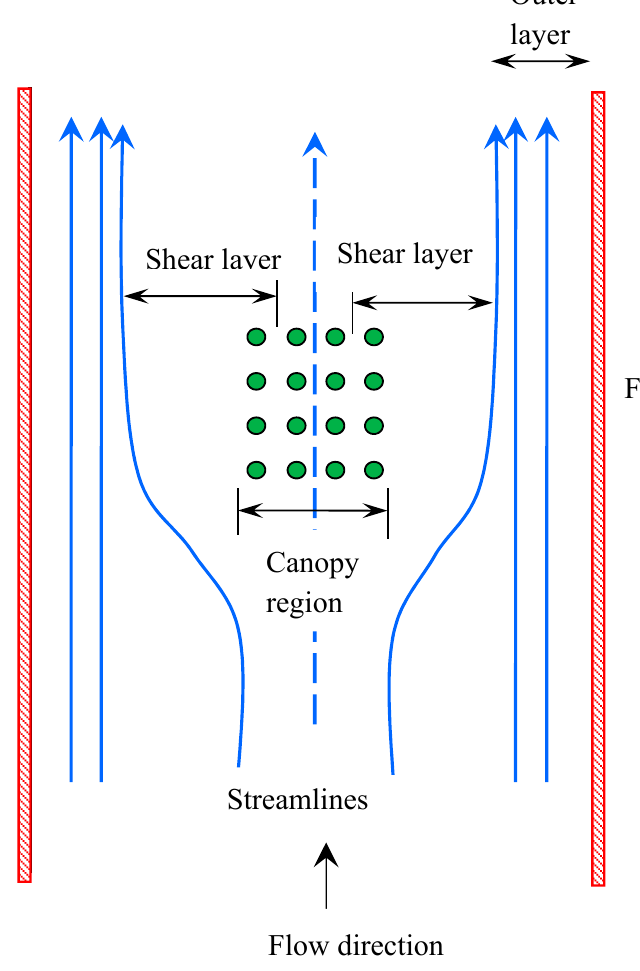
Figure 5. Horizontal structure of the flow through a vegetation patch.